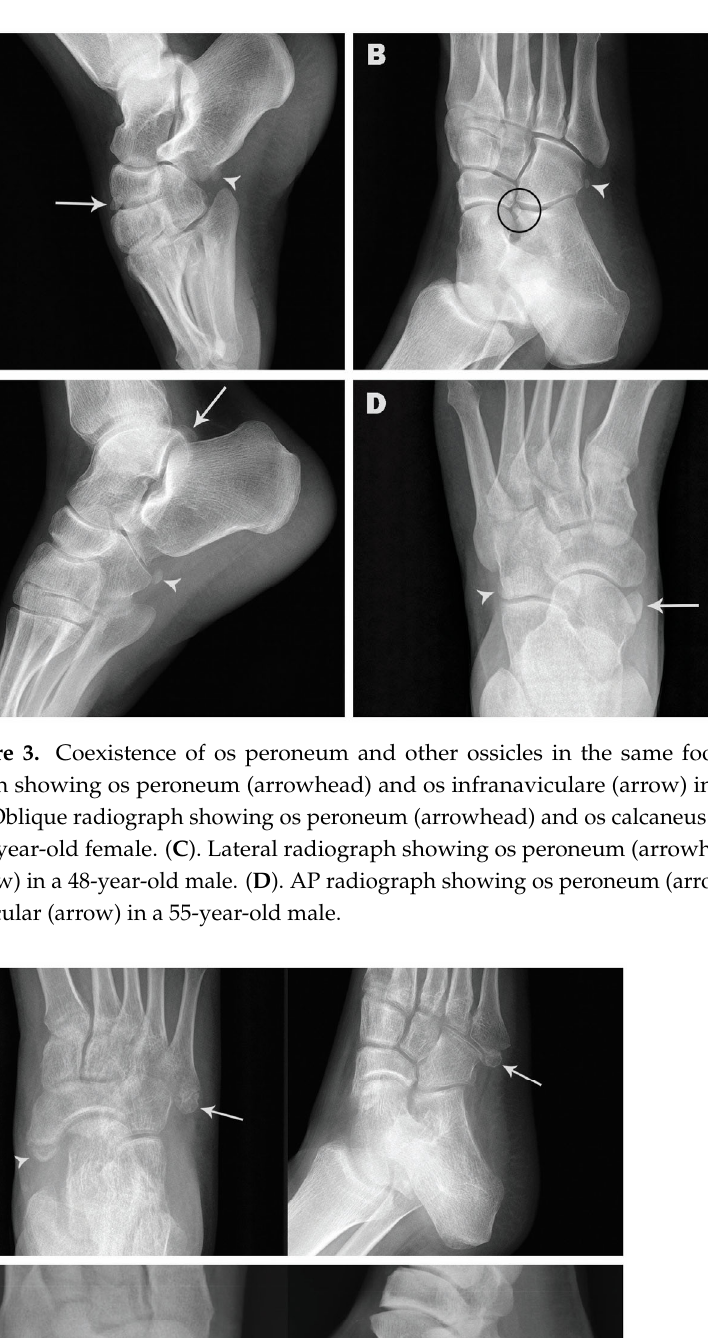
Figure 5. Radiographs showing bipartite ossicles (arrows). ( A ). Lateral radiograph showing bipar ‐ tite supratalare in a 44 ‐ year ‐ old female. ( B ). AP radiograph showing bipartite os peroneum in 50 ‐ year ‐ old male. Kappa statistics on interobserver agreement are shown in Table 2. Interobserver agreement over identification of different accessory ossicles was almost perfect (kappa > 0.9) except for os supratalare, os subtibiale, os intermetatarseum, os calcaneus secunda ‐ rius, and os infranaviculare, the agreement was substantial (kappa between 0.61 and 0.80). Table 2. Interobserver reliability (Kappa) for the detection of accessory ossicles. 95% Confidence Interval Accessory Ossicle